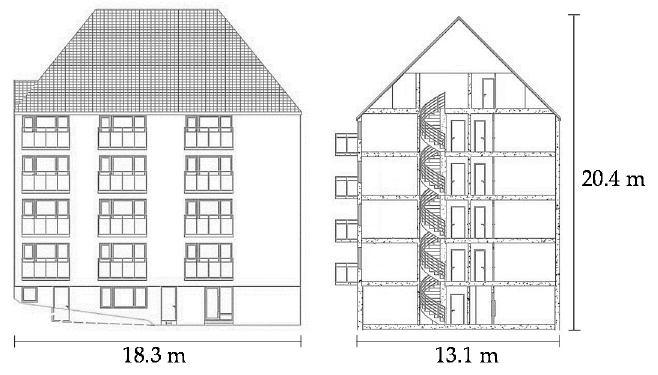
Figure 2. Façade facing south (left) and cross section of building (right).